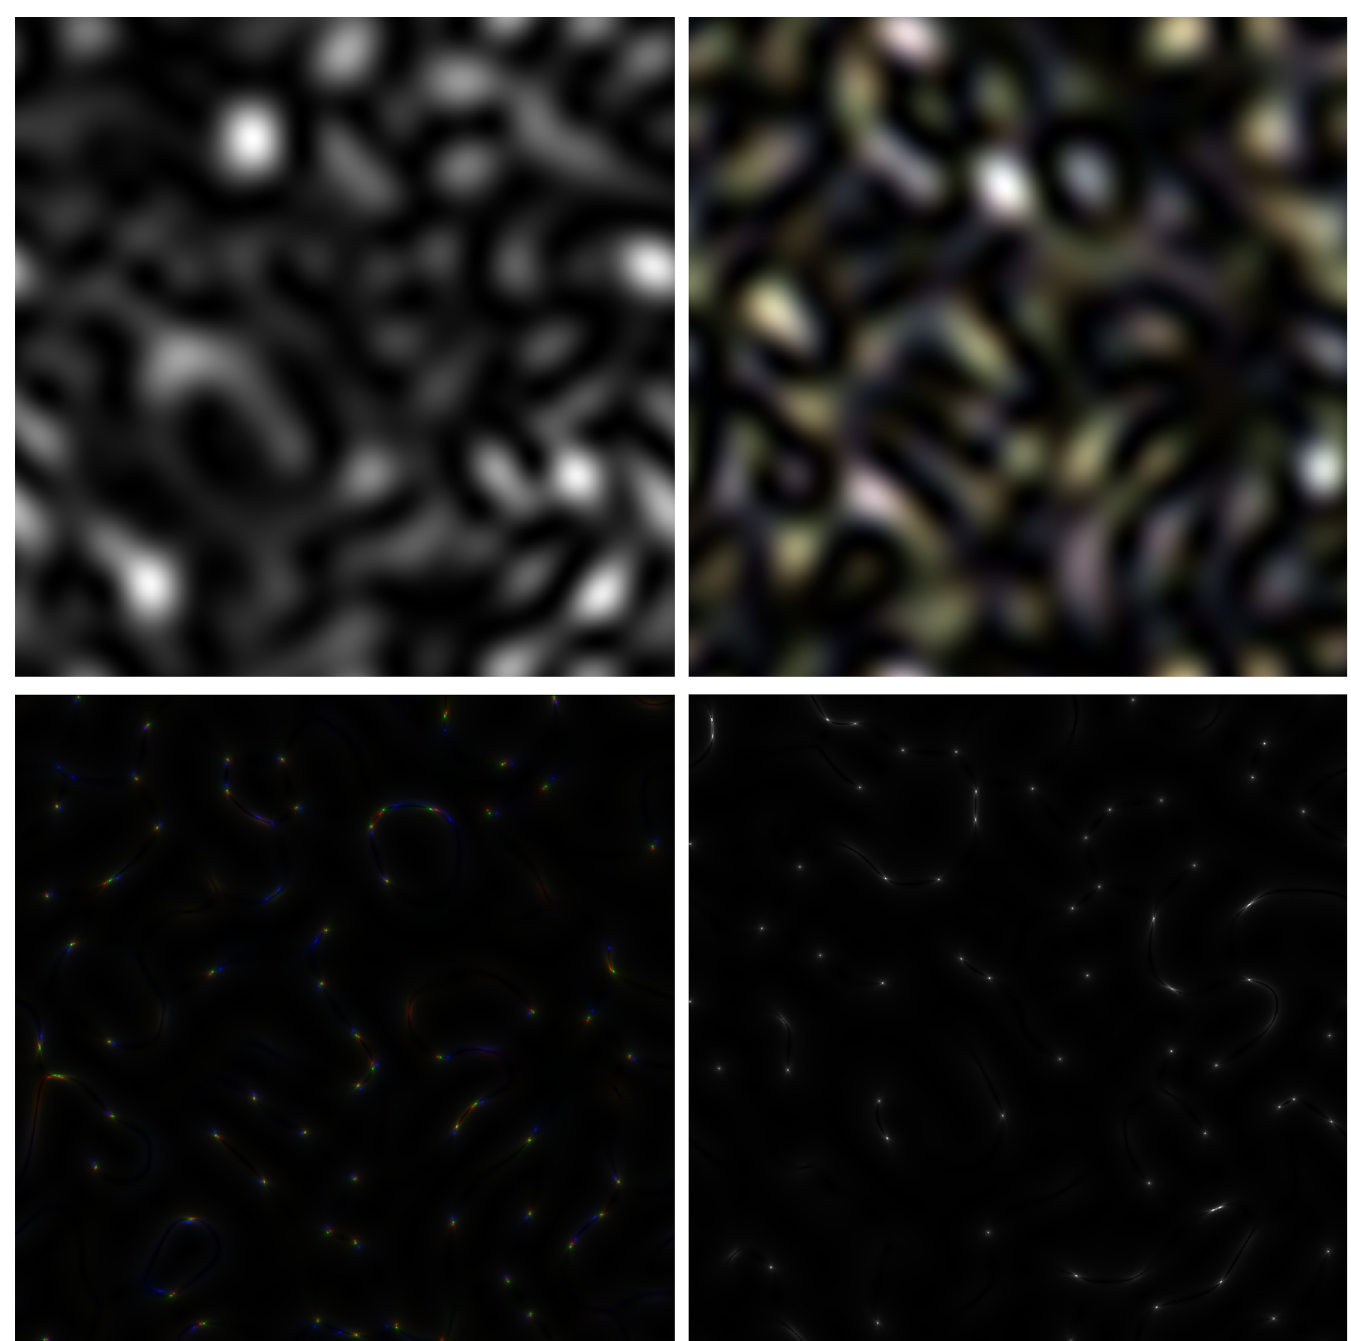
Fig 5. Colored images of GB-speckles. (a) Gene gatA . Red component is generated for the C . trachomatis E/Bour, ST94 strain, green is for the C . trachomatis G/9301, ST 95 strain, and blue is for the C . trachomatis G/11222, ST94 strain). Color picture looks like a grey-scale image. (b) Gene hflX (Red component is generated for the C . trachomatis E/Bour, ST94 strain, green is for the C . trachomatis G/9301, ST 95 strain, and blue is for the C . trachomatis G/11222, ST94 strain). (c) Colored s-LASCA images of GB-speckles. Gene hflX (Red component is generated for the C . trachomatis E/Bour, ST94 strain, green is for the C . trachomatis G/9301, ST 95 strain, and blue is for the C . trachomatis G/11222, ST94 strain). Parameter AS = 2. (d) Colored s-LASCA images of GB-speckles. Gene gatA (Red component is generated for the C . trachomatis E/Bour, ST94 strain, green is for the C . trachomatis G/9301, ST 95 strain, and blue is for the C . trachomatis G/11222, ST94 strain). Parameter AS = 2. Color picture again looks like a grey-scale image.